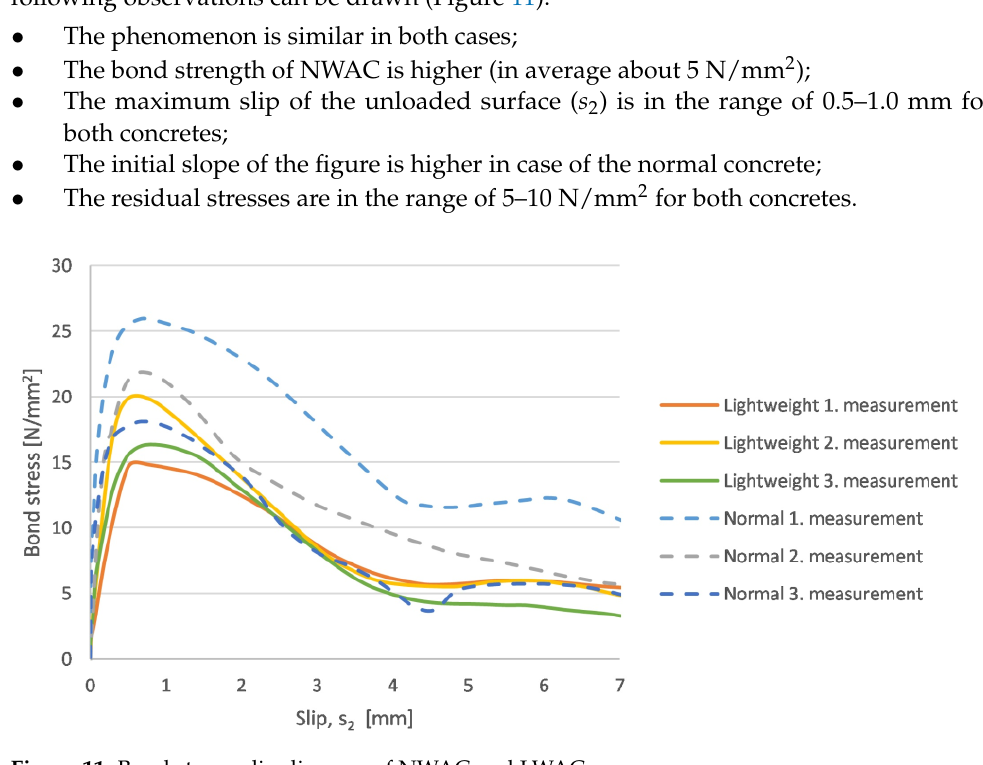
Normal Concrete